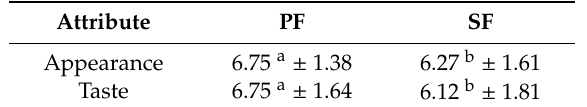
Table 7. Least significant means for overall acceptance of cabanossi made with either pork backfat (PF) or sheep tail / backfat